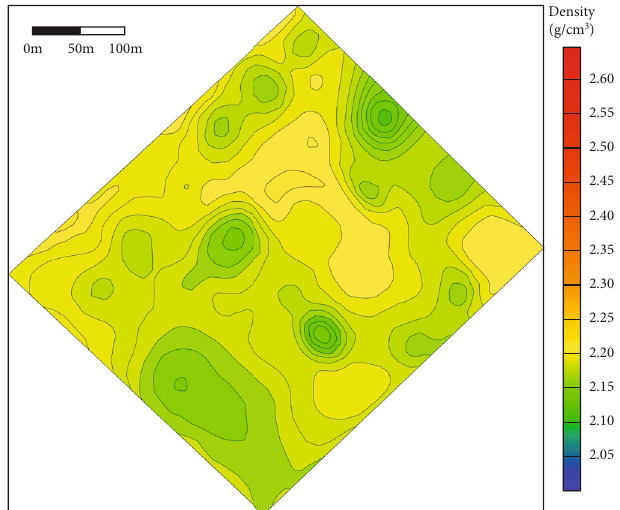
Figure 5: Map of weighted average of initial density volume